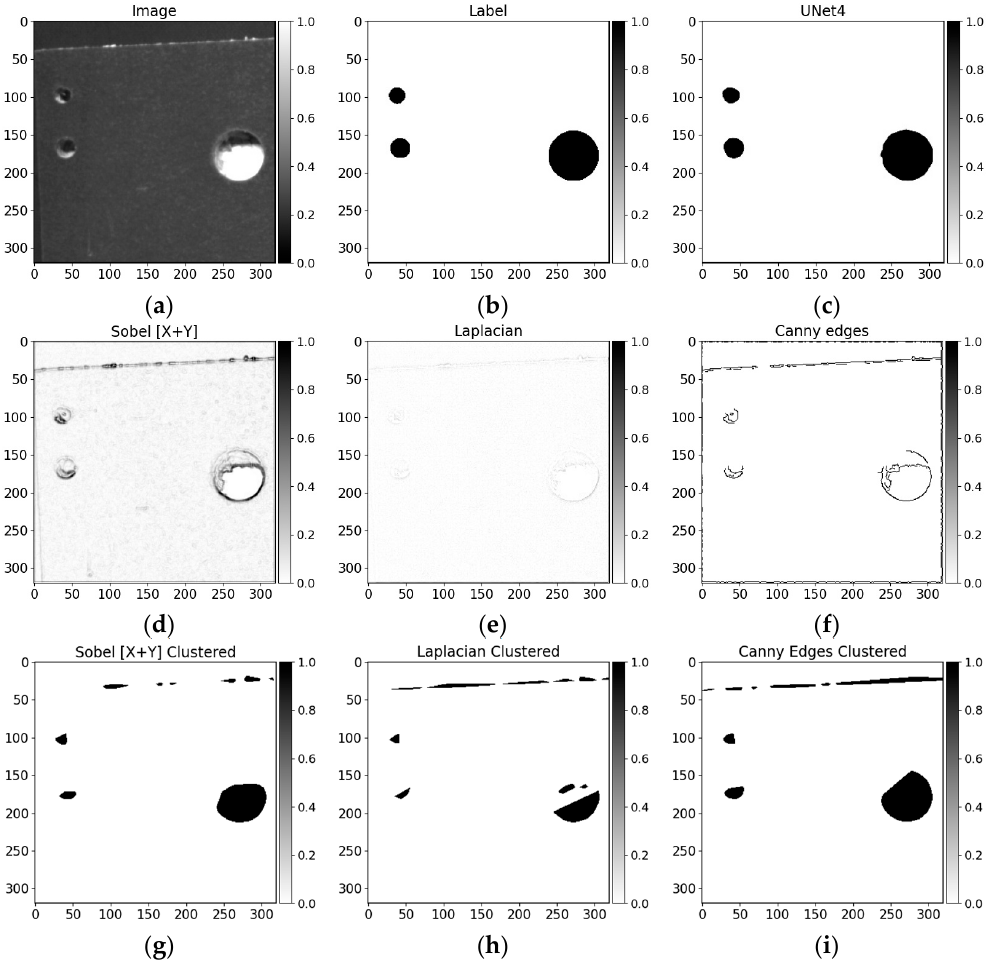
Figure 12. ( a ) Image, ( b ) label, ( c ) U-Net prediction, ( d ) Sobel filter, ( e ) Laplace filter, ( f ) Canny edges detector, ( g ) Sobel filter clustered, ( h ) Laplace filter clustered, ( i ) Canny edges detector clustered.